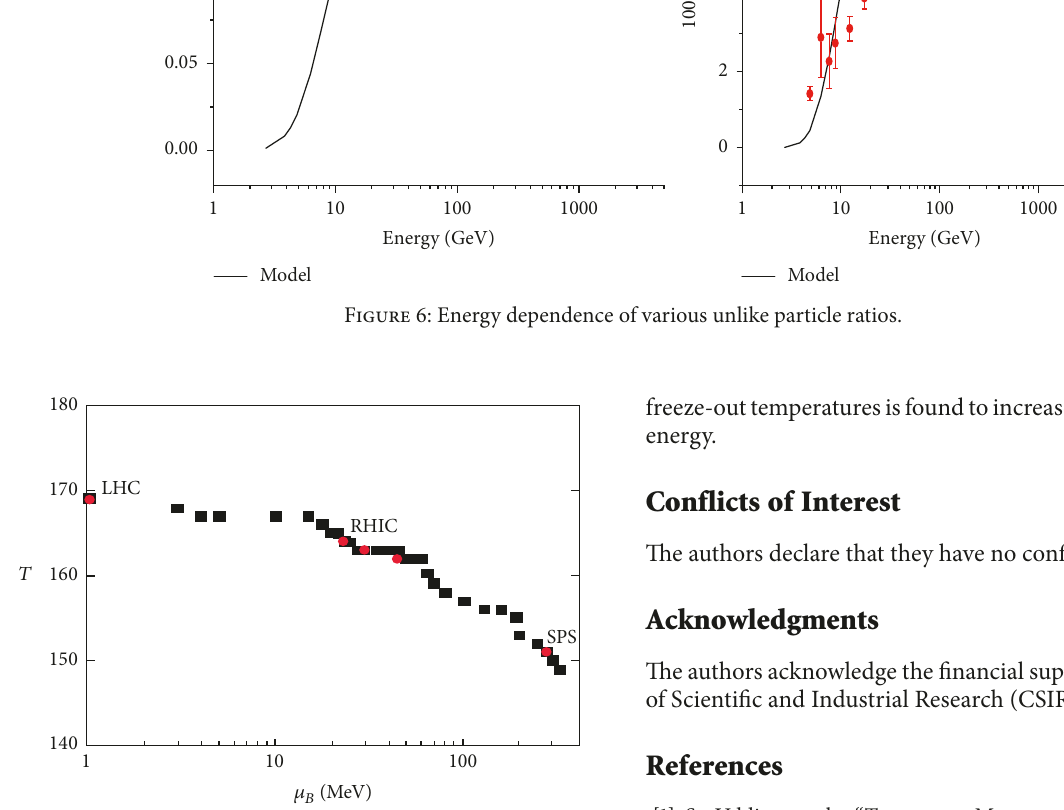
Figure 7: Chemical freeze-out temperature 𝑇 versus mid-rapidity baryon chemical potential 𝜇 𝐵 at different collision energies. The red squares represent the values of chemical potentials obtained at various collision energies as mentioned in Table 1. The black squares are the results from the present